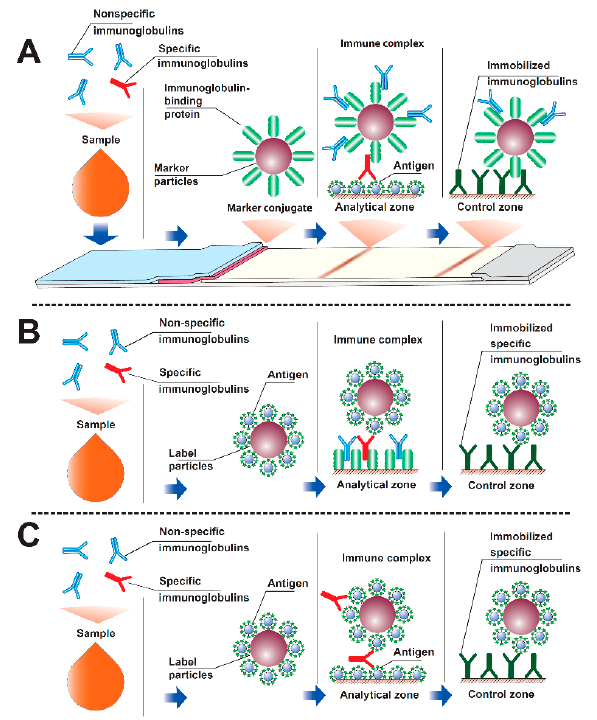
Figure 1. The three serodiagnostic immunochromatography formats: ( A ) with labeled immunoglobulin-binding protein and immobilized antigen in the analytical zone; ( B ) with labeled antigen and immobilized immunoglobulin-binding protein in the analytical zone; ( C ) with labeled antigen and immobilized antigen in the analytical zone (see additional comments in the paper).